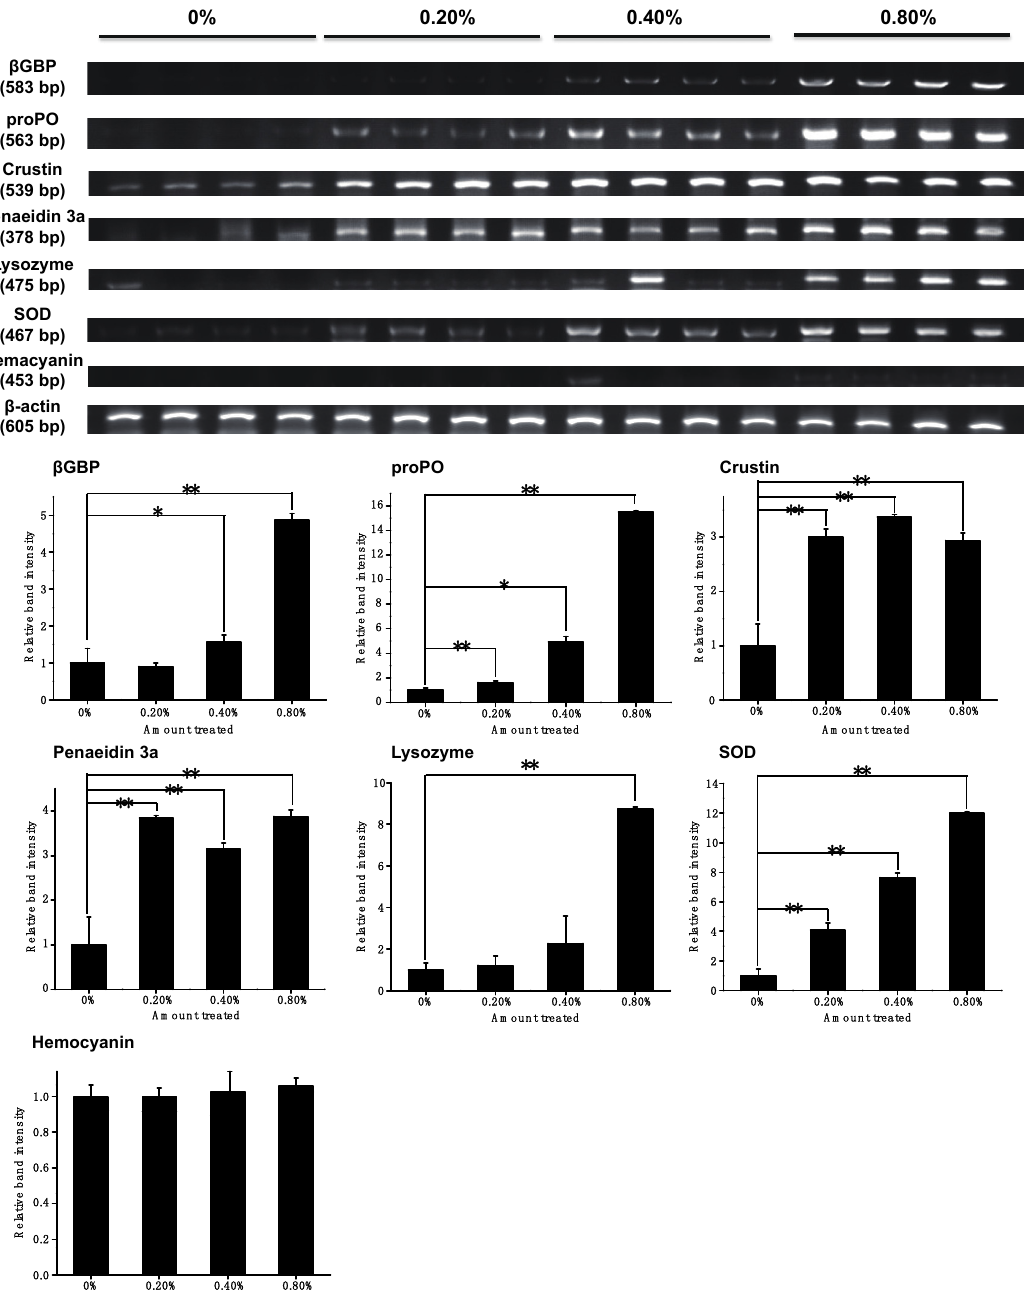
Figure 2. Transcription level of genes related to innate immunity in L. vannamei after treatment with kefir. ( A ) The amplified cDNA genes related to innate immunity in L. vannamei after treatment with kefir. ( B ) Quantification of the amplified cDNA genes related to innate immunity in L. vannamei using ImageJ. For quantification of the amplified cDNA genes, the intensity of the amplified cDNA in four wells was averaged and normalized by dividing with amplified cDNA intensity of the non-treated group. * p < 0.05 and ** p < 0.01, accessed using the paired t test.